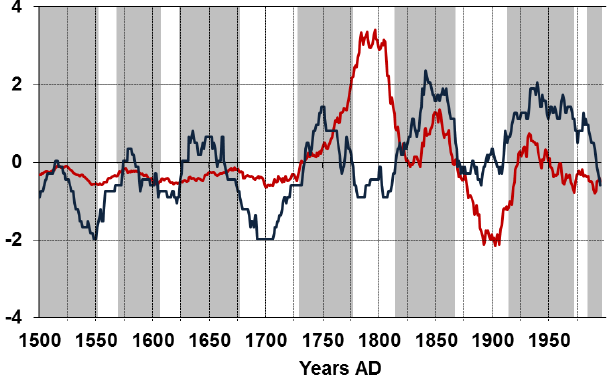
Figure 6. The z -transformed time series of annual 31-year running flood frequencies in the Bavarian Foreland (blue) and of annual 31- year running NAOI (red) (NAOI data after Luterbacher et al., 2002). Grey bars indicate the flood-rich periods #3–#9 based on the full- year development.